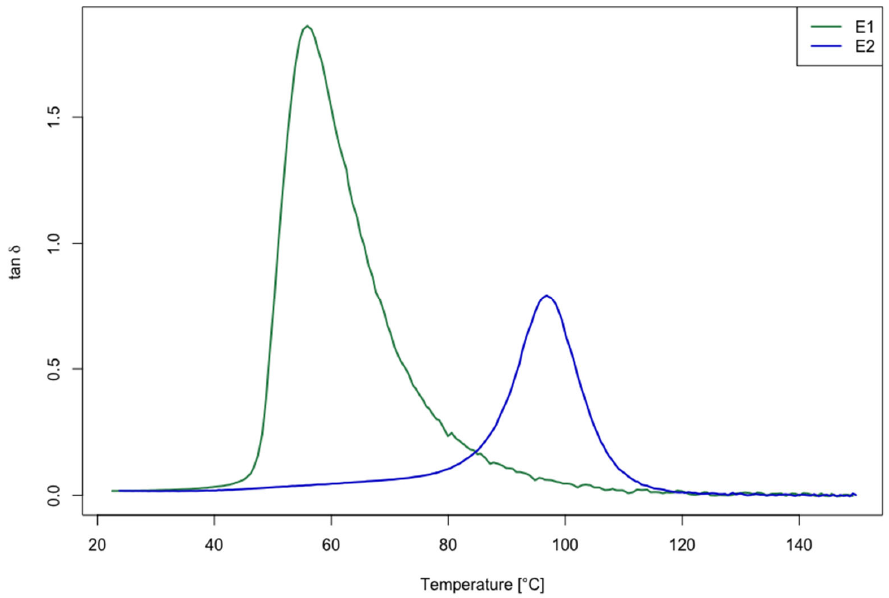
Figure 2. DMA results: tan δ versus temperature plot for E1 (green curve) and E2 (blue curve) epoxy systems.